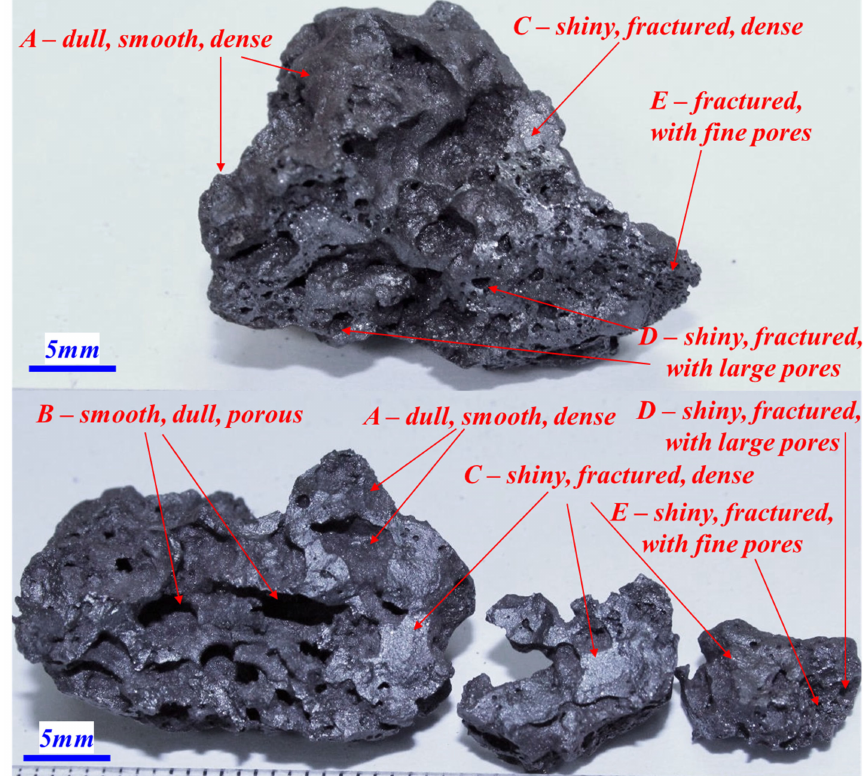
Figure 2. Example of Macro-Types A~E on industrial sinter